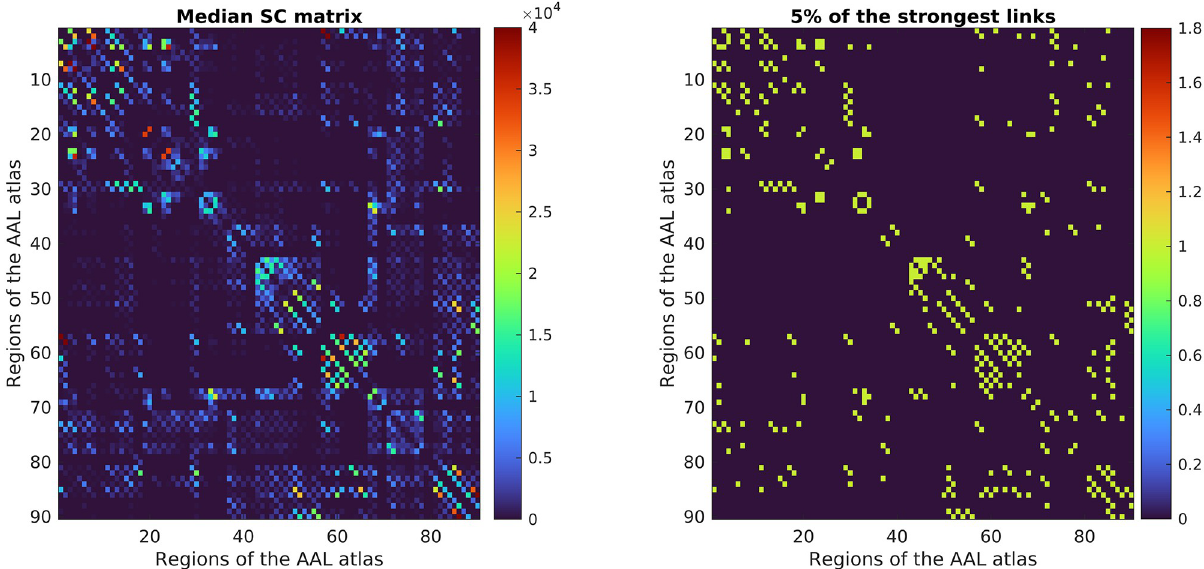
Fig 2. Median Structural Connectivity (SC) matrix. SC containing the median number of streamlines of 46 patients included in the analysis (left) and binary matrix with highlighted 5% of the strongest links (right). Each row/column represents an area of the AAL atlas (in the original order).